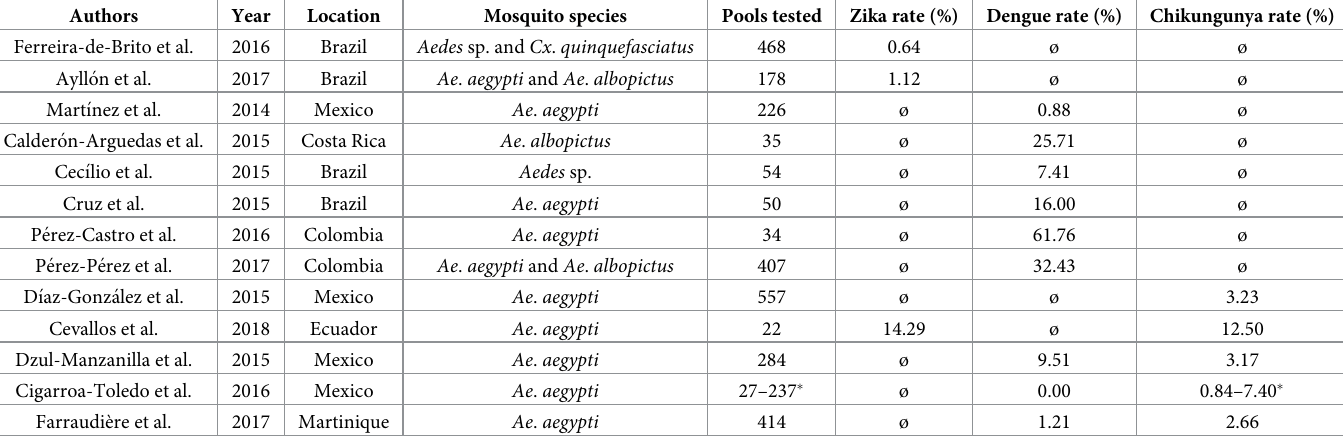
Table 2. List of studies that report a proportion of positive mosquito pools for any or a combination of Zika, dengue and chikungunya viruses, along with informa- tion on authors, year and country of location of the study, and mosquito species of